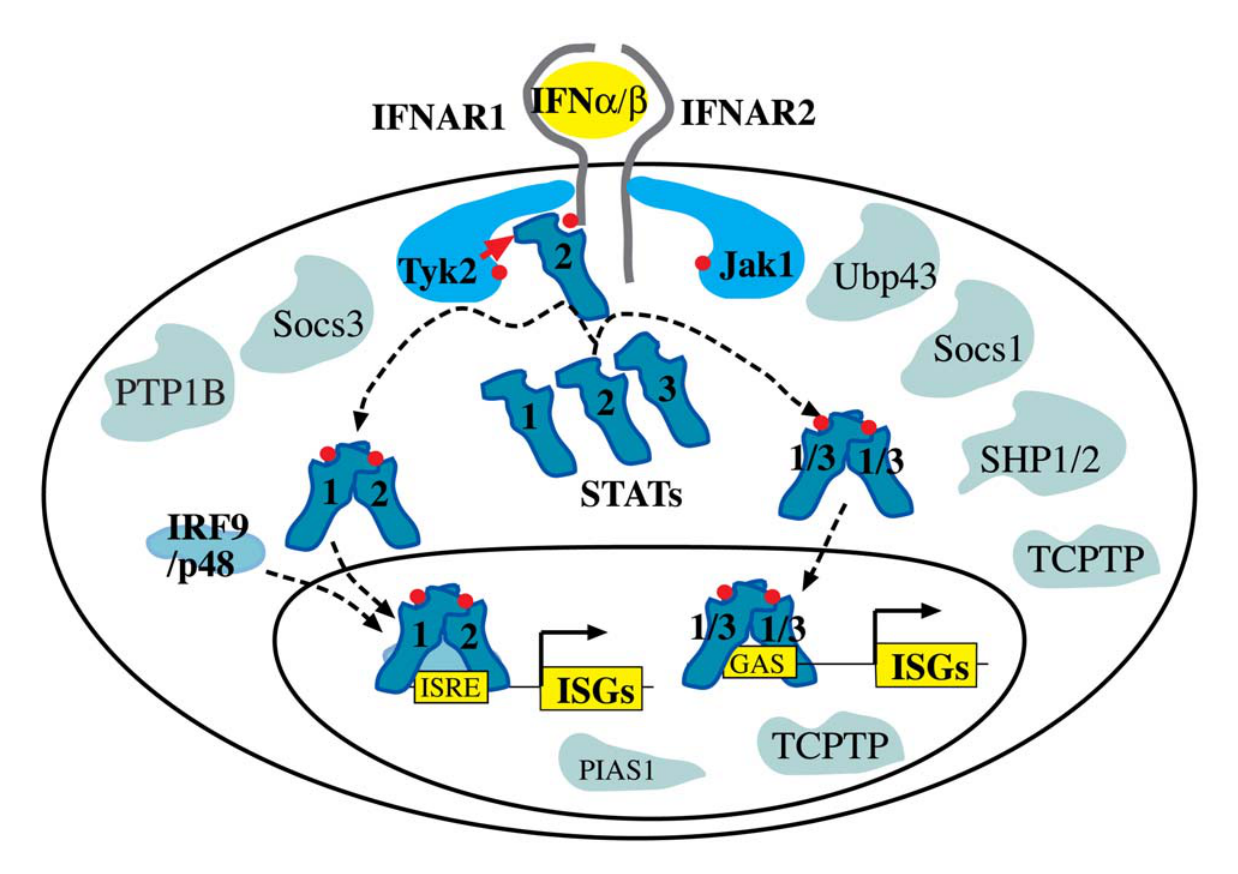
Figure 2. Type I IFNs signal through the Jak-STAT pathway. PTP1B, protein tyrosine phosphatase 1B; SHP1/2, SH2 domain-containing protein tyrosine phosphatase1 or 2; TCPTP, T cell protein tyrosine